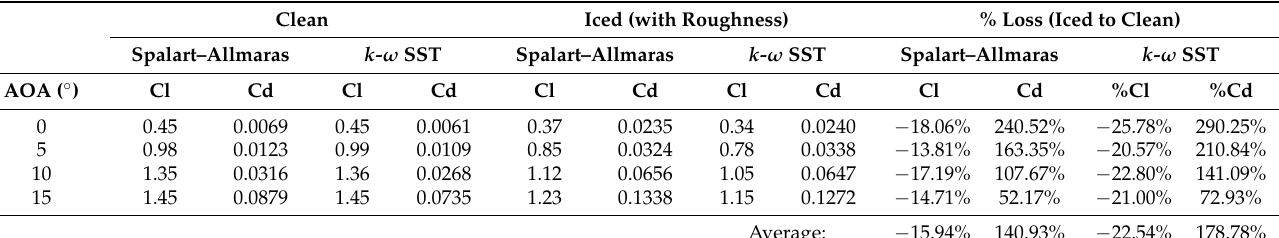
Table 7. Aerodynamic loss estimated with roughness